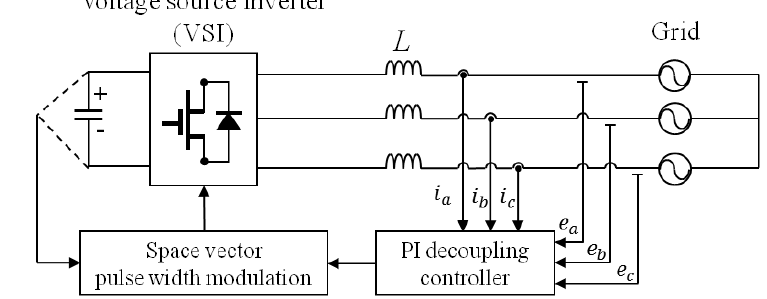
Figure 1. Block diagram of three-phase grid-connected inverter.